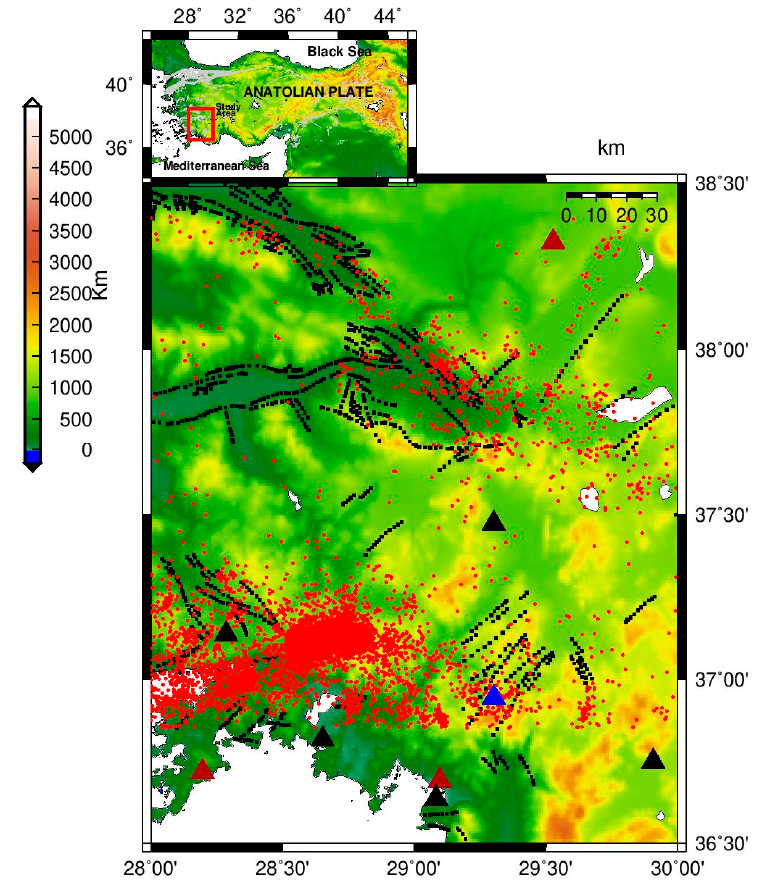
Figure 2. A simpli fi ed tectonic, seismic activity, and seismic station map of Denizli and surroundings. Figure 2. A simplified tectonic, seismic activity, and seismic station map of Denizli and